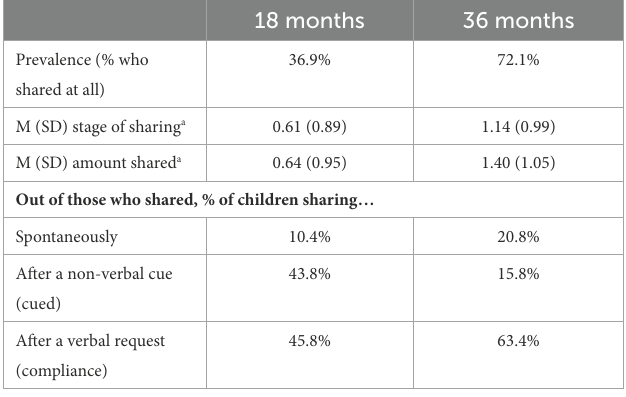
TABLE 2 Descriptive statistics for sharing